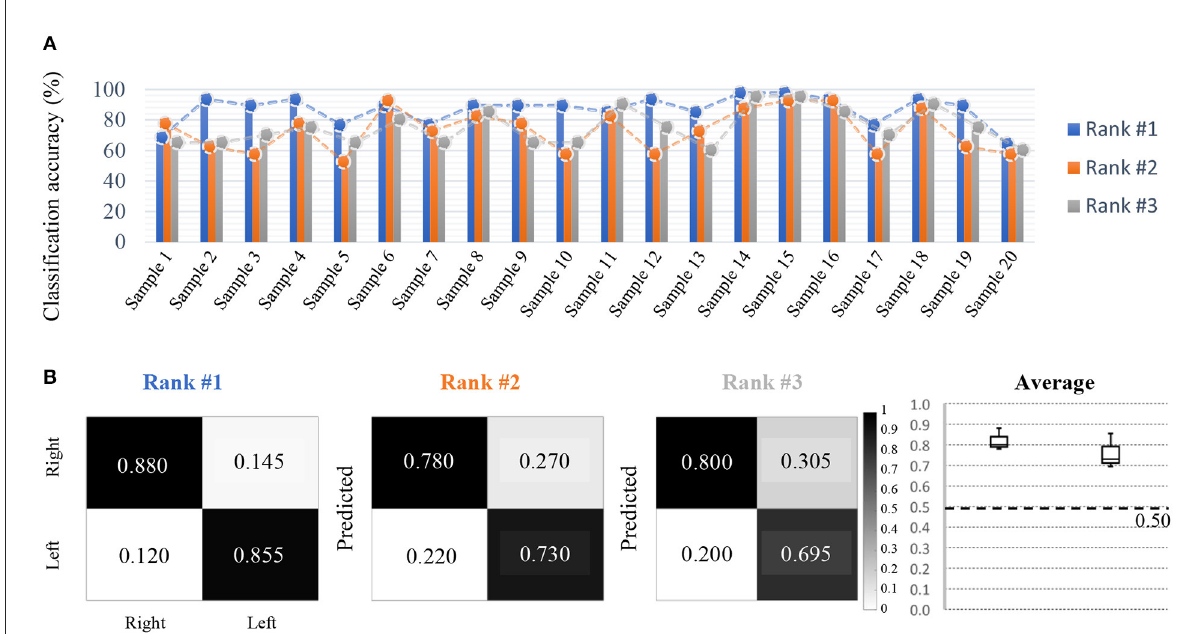
FIGURE3 Competition outcomes. (A) Decoding results on short-calibration BCI (Accuracy), where the difference between the top performer and the other two performers are significant, but the difference between the second and third places is not significant. All participants demonstrate consistent decoding performance regarding the samples used. For short-calibration BCI, both right-hand MI and left-hand MI classes were used. (B) Despite using a small amount of data, on average, the true positive rate and performance were approximately 0.200 (20%) higher